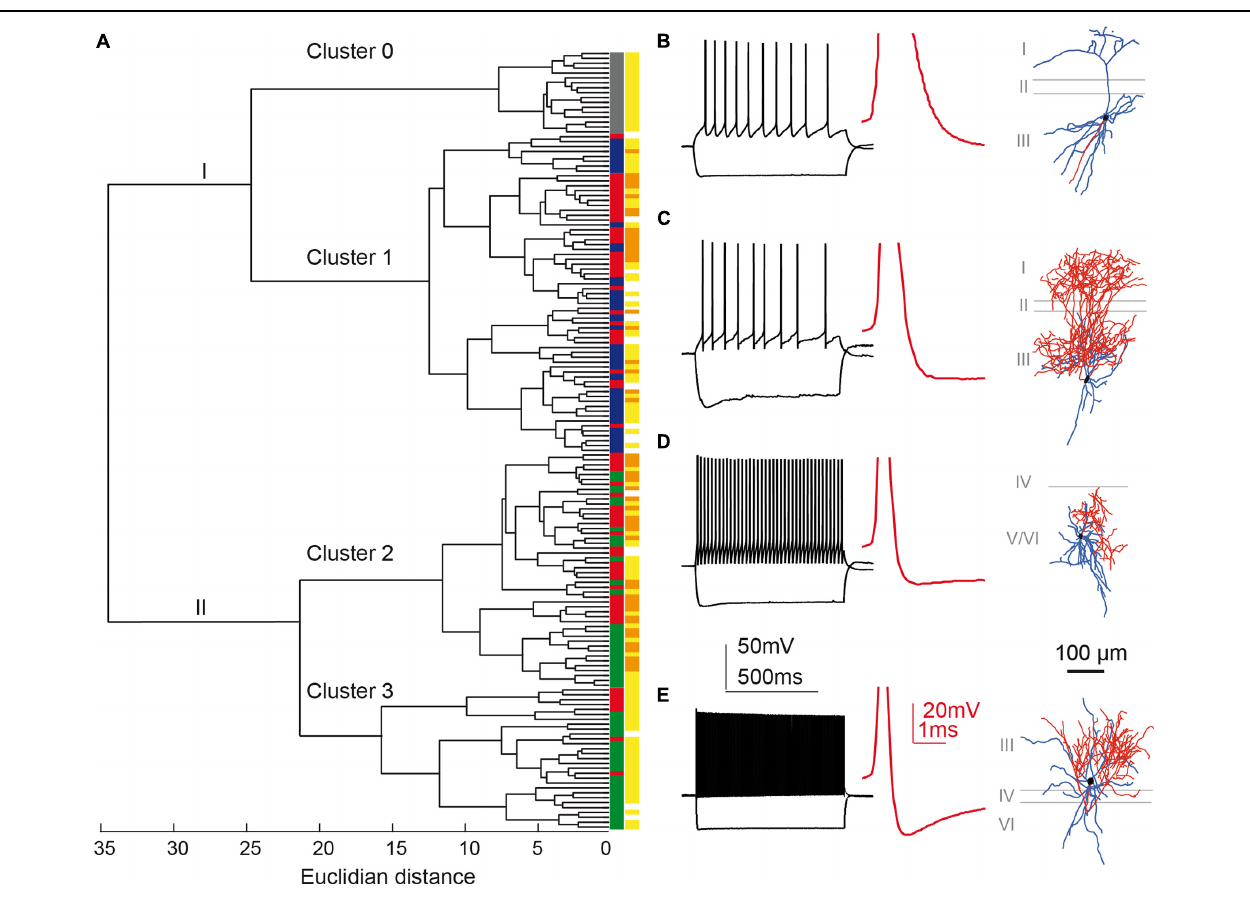
FIGURE 5 | Cluster analysis classification of presubicular interneurons and pyramidal cells. Ward’s unsupervised analysis was used with physiological parameters from Table 1 to classify 17 unlabeled pyramidal cells and 142 fluorescent interneurons from the three mouse lines. (A) Dendrogram. Pyramidal cells are isolated in cluster 0 (labeled gray). (B) shows a typical pyramidal cell firing pattern and morphology. A cut-off at a Euclidean distance of 20, separated interneurons into clusters 1, 2, and 3. Cluster 1 includes putative SST interneurons from the X98 (blue) and Sst-Cre (red) mouse lines. Cluster 2 includes both Sst-Cre (red) and Pvalb-Cre (green) interneurons. Cluster 3 contains mostly fast-spiking